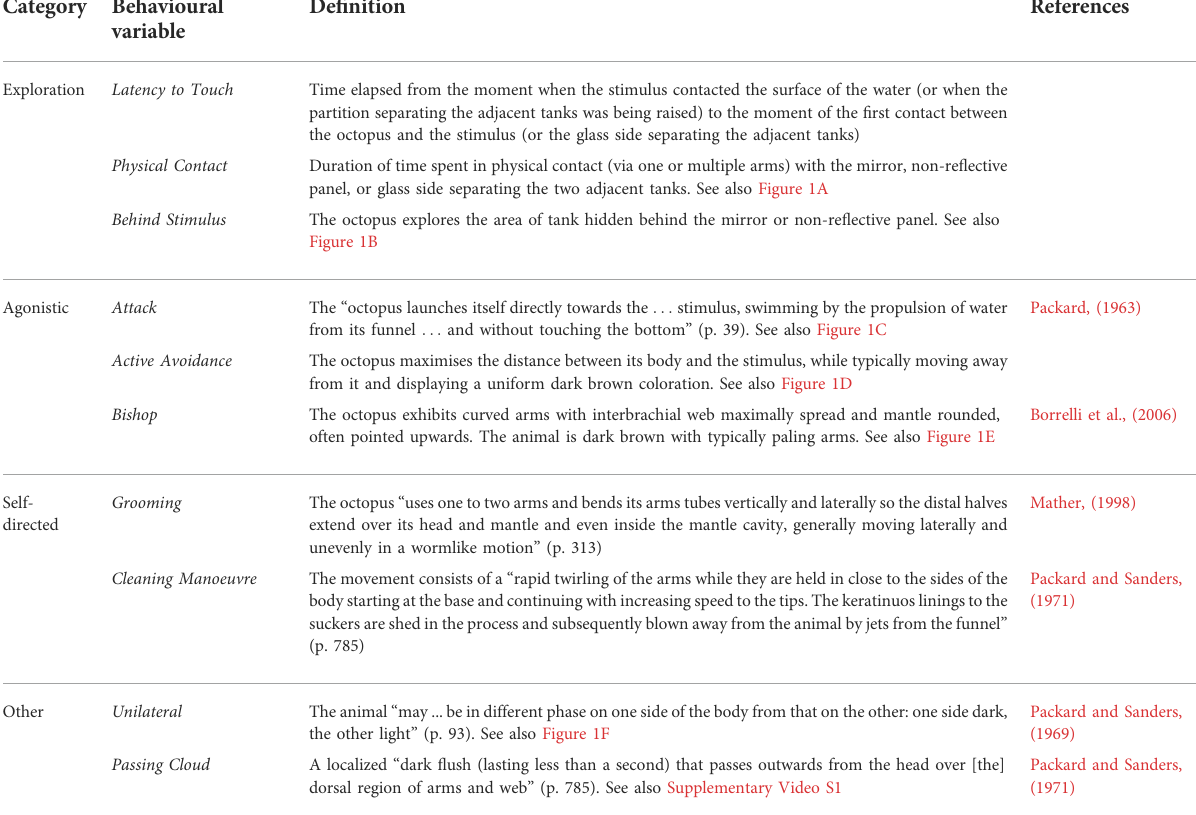
TABLE 1 De fi nitions of the behavioural variables that were scored in the